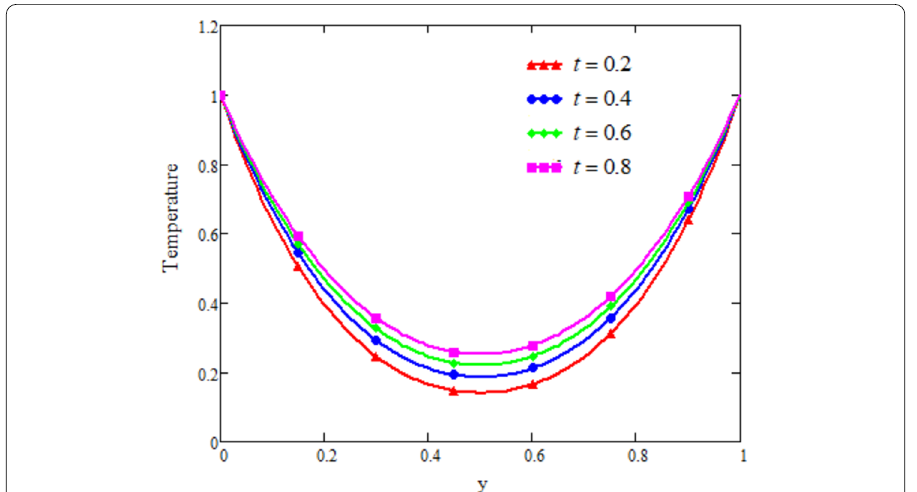
Figure 4 Temperature curves along t variation and P r = 12, α = 0.5